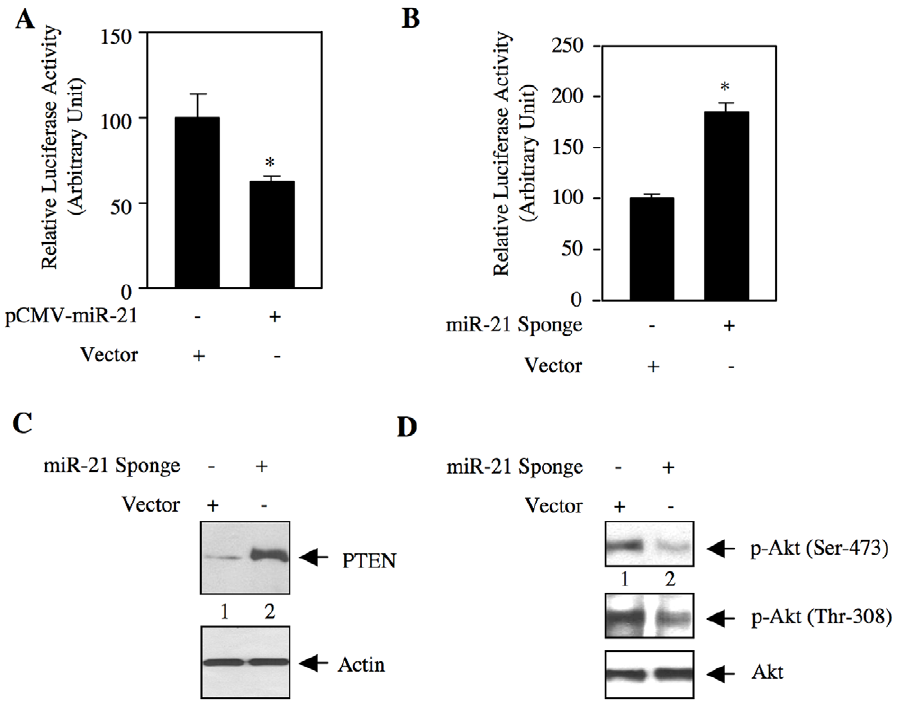
Figure 4. miR-21 regulates expression of PTEN in renal cancer cells. (A and B) ACHN cells were transfected with pCMV-miR-21 expression plasmid (A) or miR-21 Sponge (B) and vector along with PTEN 3 9 UTR-Luc reporter construct. The cell lysates were used to determine luciferase activity as described in the Materials and Methods. Mean 6 SE of 6 measurements is shown. In panel A, *p =0.02 vs vector alone. In panel B, *p =0.002 vs vector alone. (C and D) Lysates of miR-21 Sponge-transfected ACHN cells were immunoblotted with PTEN and actin antibodies (panel C), and phospho-Akt (Ser-473), phospho-Akt (Thr-308) and Akt antibodies (panel D).